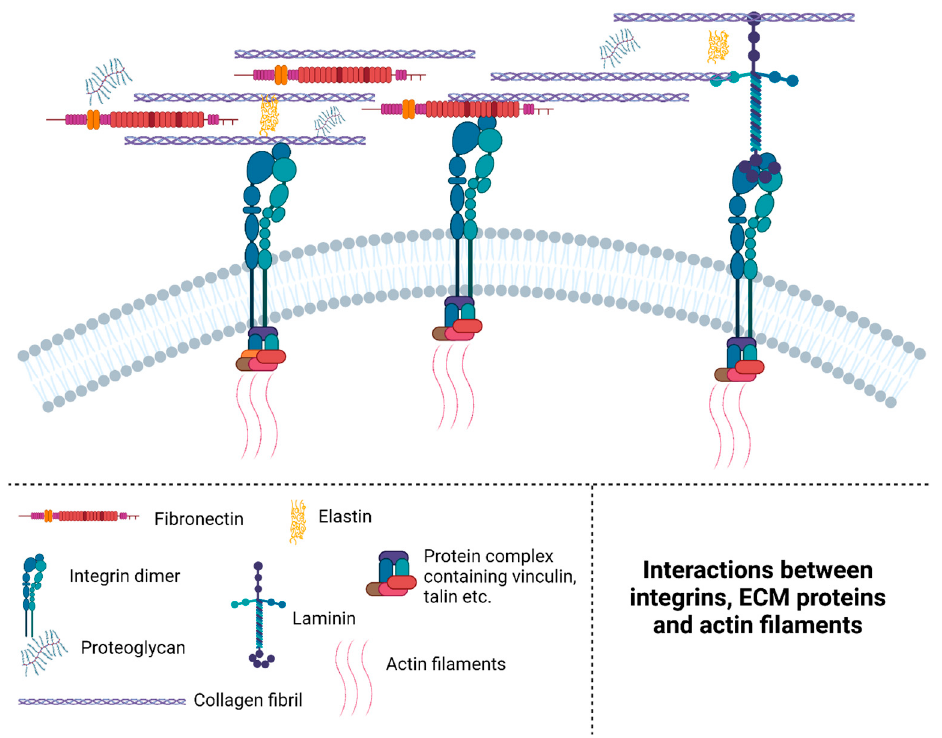
Figure 1. Interactions between integrins, ECM proteins and actin filaments. Integrins are important components in the anchoring of cells to the ECM, and also in the ability of the cell to sense and respond to mechanical stimuli of the environment. On the intracellular surface, integrin binds actin filament through a protein complex containing, amongst other proteins, vinculin and talin. On the extracellular surface, the integrin dimer is capable of interacting with a number of ECM proteins, such as laminin, collagen and fibronectin. Created using BioRender.com.